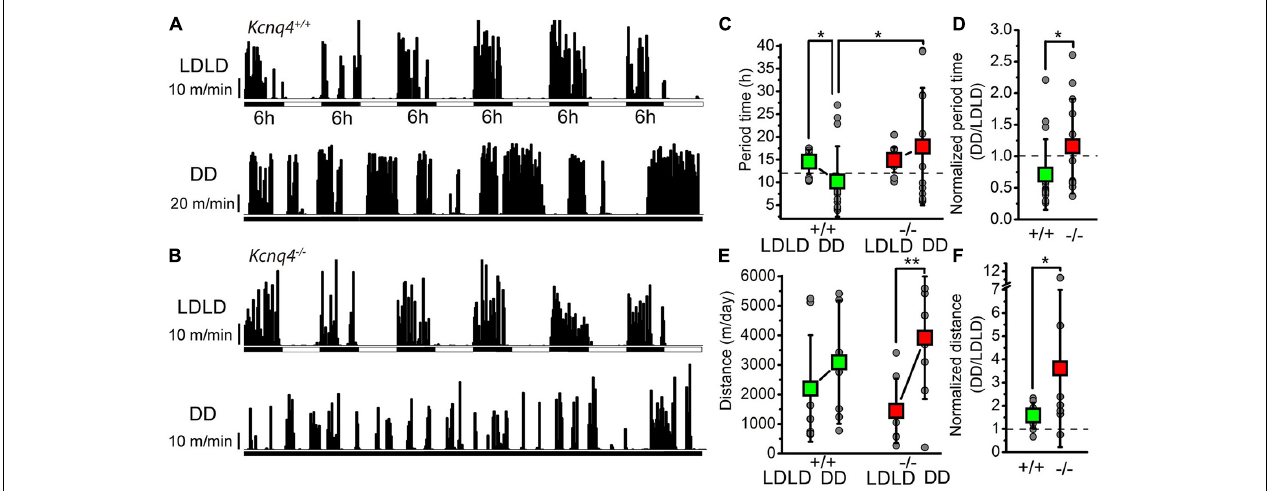
FIGURE 1 | KCNQ4 knockout (KO) mice show alterations of the activity cycle adaptation to changes in light–darkness conditions with the activity wheel test. (A) Activity cycles recorded with a wild-type (WT) mouse ( Kcnq4 + / + ) with 6-h alterations of light–darkness cycles (LDLD) and in complete darkness (DD). Black vertical bars represent the distances ran in 10-min bins. (B) Activity cycles with the same arrangement as in panel (A) for KCNQ4 KO mouse ( Kcnq4 − / − ). (C) Statistical comparisons of the alterations in period length under the LDLD and DD conditions with WT (+/+) and KO (–/–) mice ( green squares : WT; red squares : KO; gray circles : individual data). Under the LDLD conditions: 14.55 ± 2.64 h for WT and 14.92 ± 2.77 h for KO. Under the DD conditions: 10.2 ± 7.72 h for WT ( p = 0.0242 compared with LDLD) and 17.88 ± 12.9 h for KO. The period times of WT and KO mice under the DD conditions were also statistically significant ( p = 0.0331). Dashed line indicates 12 h. (D) Period times under the DD conditions normalized to the LDLD conditions of each case with the same arrangement as in panel (C) ( dashed line : 1). The normalized value for the WT was 0.71 ± 0.56 and for the KO was 1.15 ± 0.76 ( p = 0.0461). (E) Comparison of the distances ran in 3 days by WT (+/+) and KO (–/–) mice under the LD and DD conditions [the arrangement is the same as that in panel (C) ] (significant difference at * p < 0.050; ** p < 0.010). For the WT, the distance ran under LDLD was 2,203 ± 1,804 m/day and that under DD was 3,091 ± 2,083 m/day. For KO mice, the distance ran under LDLD was 1,445 ± 1,088 m/day and that under DD was 3,919 ± 2,075 m/day ( p = 0.0049). (F) Distances ran under the DD conditions normalized to the LDLD conditions for each case with the same arrangement as in panel (C) ( dashed line : 1). The normalized value for the WT was 1.58 ± 0.55 and that for KO was 3.6 ± 3.39 ( p =